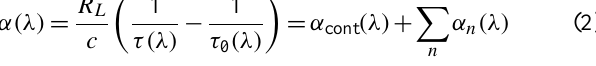
(cid:12) (cid:12) 0 i f | 4 i b | 0 i OH b